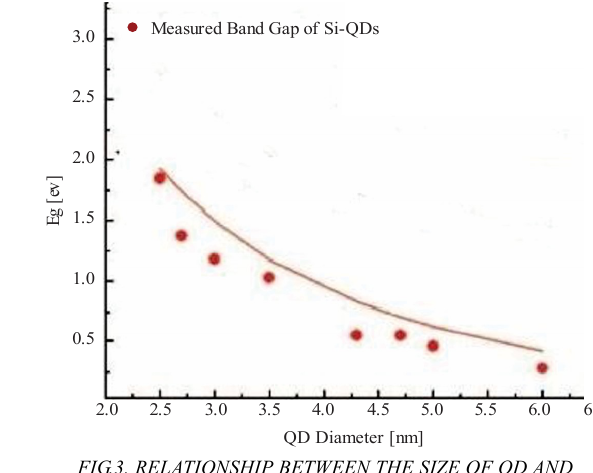
FIG.3. RELATIONSHIP BETWEEN THE SIZE OF QD AND BAND GAP [14] TABLE 1: SOLAREX MSX60 SPECIFICATION (1 KW/m 2 &